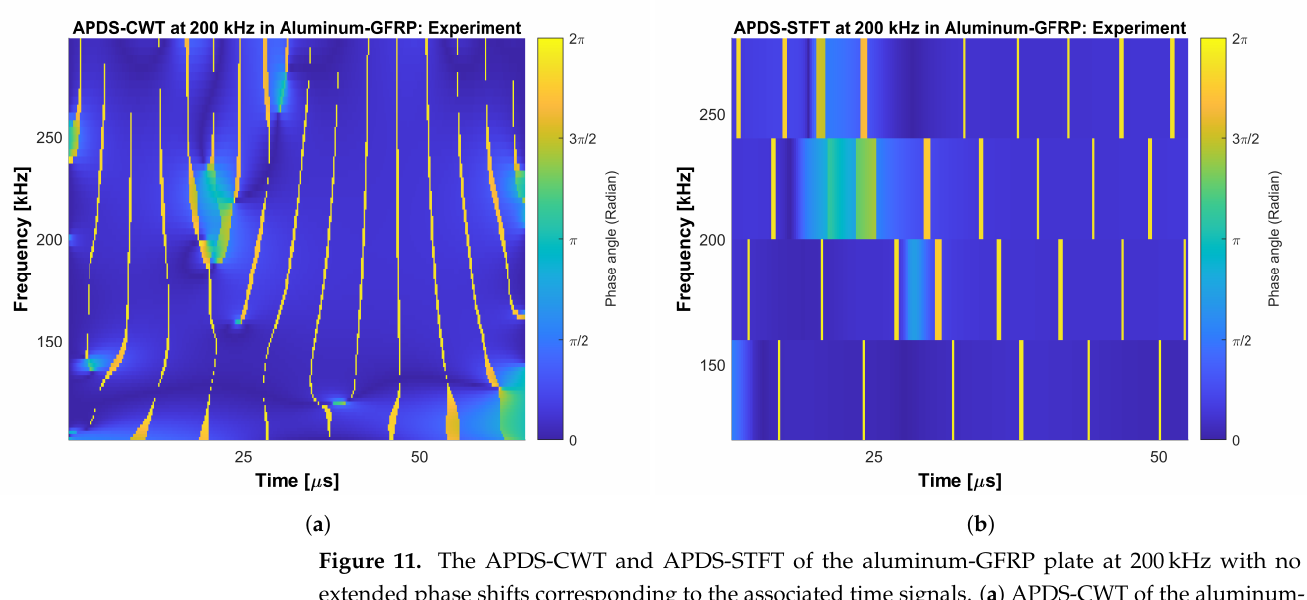
Figure 11. The APDS-CWT and APDS-STFT of the aluminum-GFRP plate at 200kHz with no extended phase shifts corresponding to the associated time signals. ( a ) APDS-CWT of the aluminum- GFRP plate at 200kHz. ( b ) APDS-STFT of the aluminum-GFRP plate at